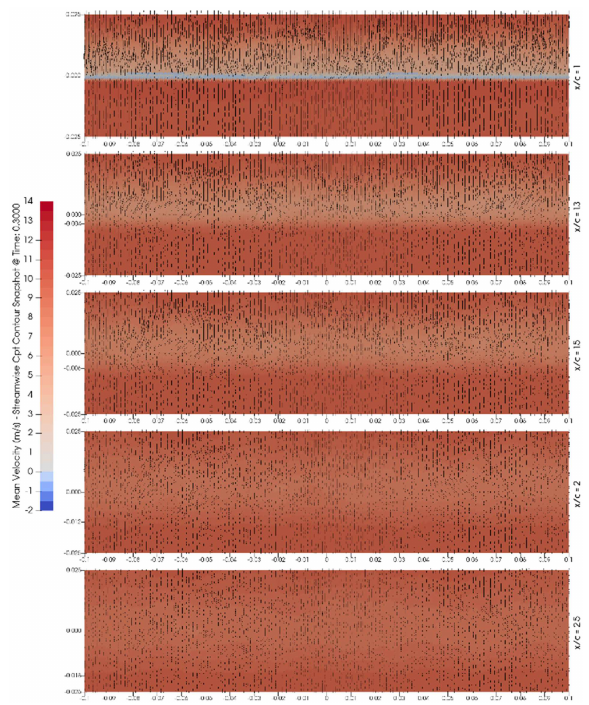
Fig. 11 . Streamwise normal planes - slices through the wake. Instantaneous spanwise velocity contours and vectors of instantaneous in-plane velocity.